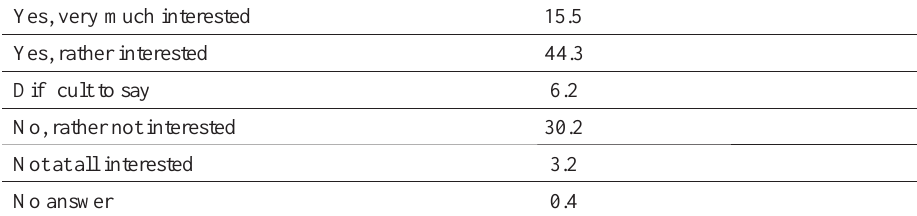
Table 2. Are you interested in the history of Minsk? (in percentage terms) Yes, very much interested Yes, rather